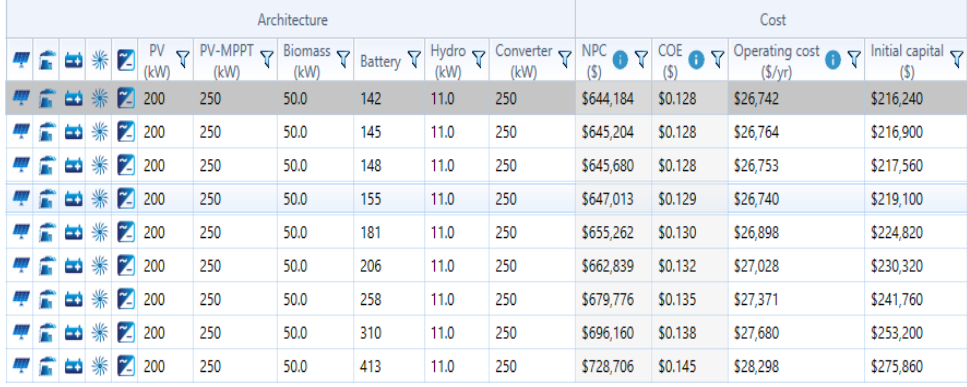
Figure 23. Simulation results for case IV (Ba/Bi/H/S).